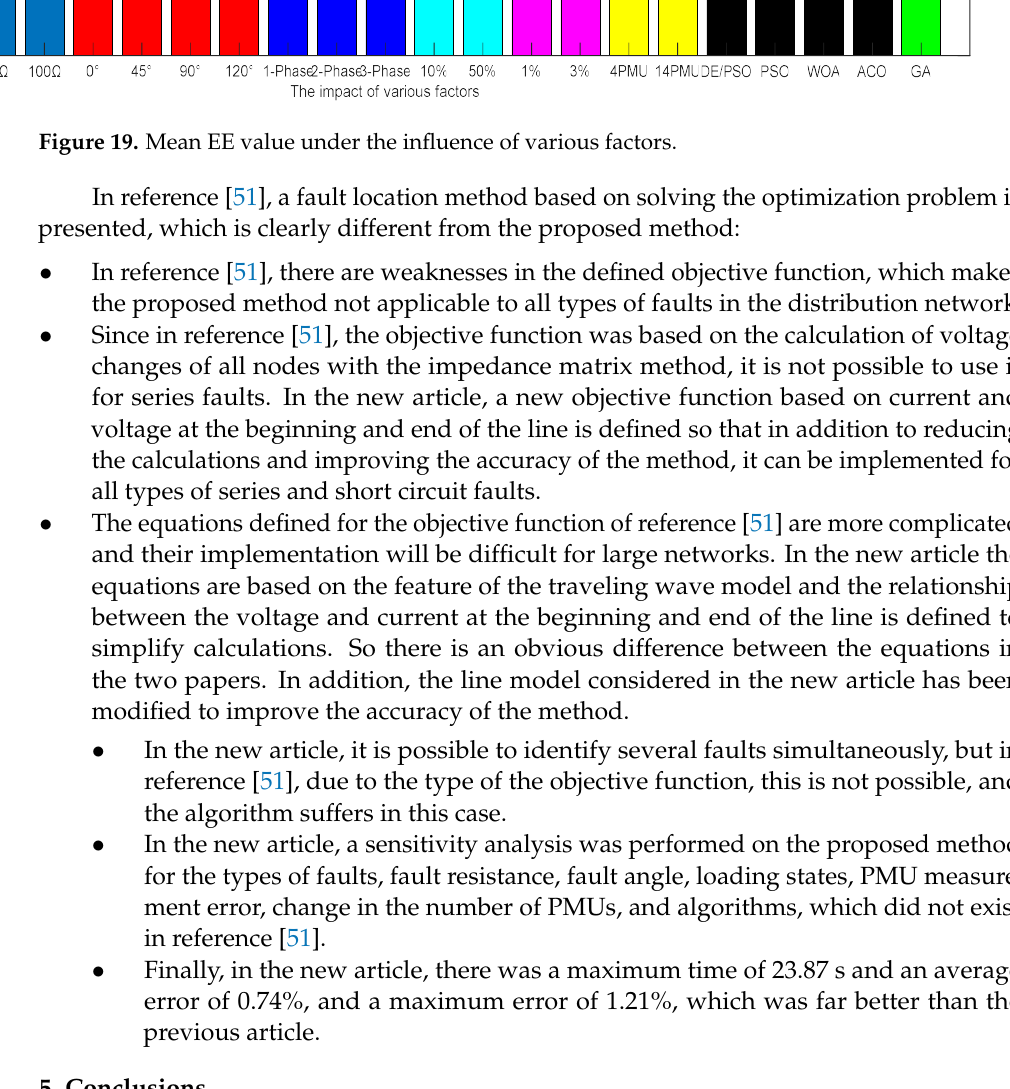
Figure 19. Mean EE value under the influence of various factors.